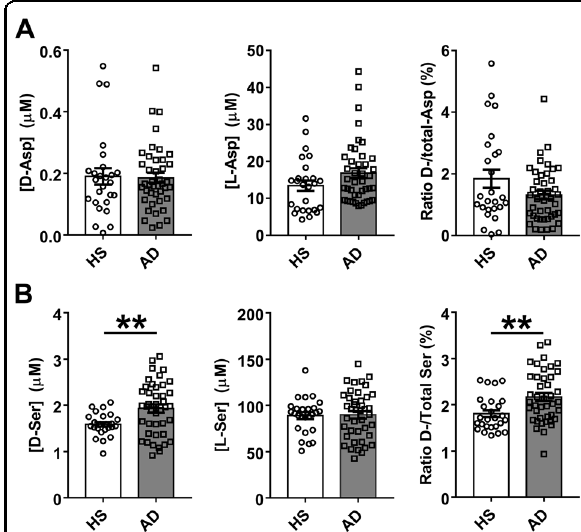
serum. D - and L -Asp ( A , left and center, respectively) and D - and L -Ser ( B , left and center, respectively) levels and ratio between D -enantiomer and total ( D + L ) amino acid content ( A , right, and B , right for Asp and Ser, respectively, expressed as percentage) detected in serum samples of AD patients compared to healthy subjects (HS). Dots and bars represent the single subjects ’ values and the standard error of the mean, respectively. ** P < 0.01 (Mann – Whitney unpaired